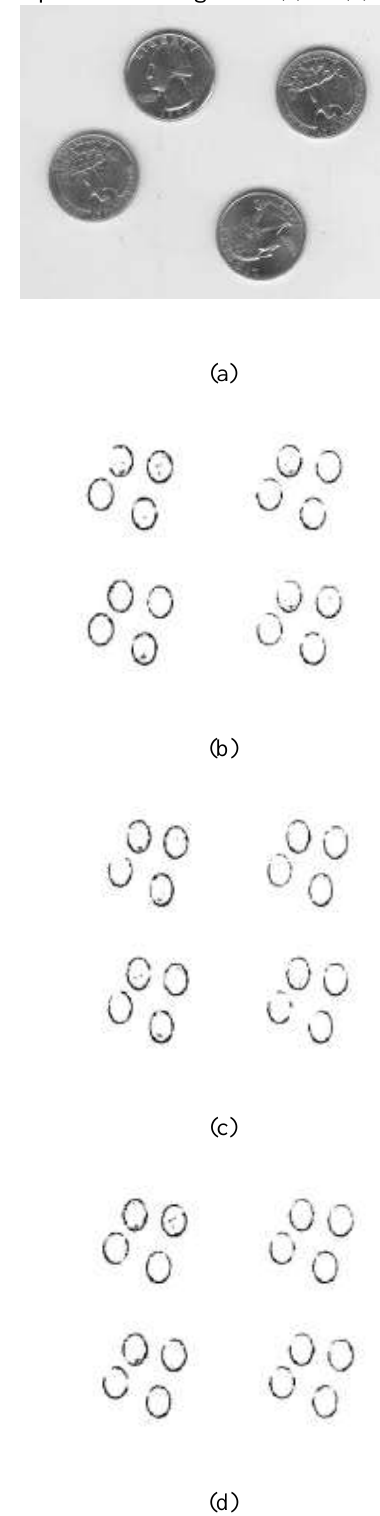
Figure 3. (a) original image (b) edge detection without noise (c) edge detection with salt and pepper noise and intensity=0.02 (d) edge detection with salt and pepper noise and